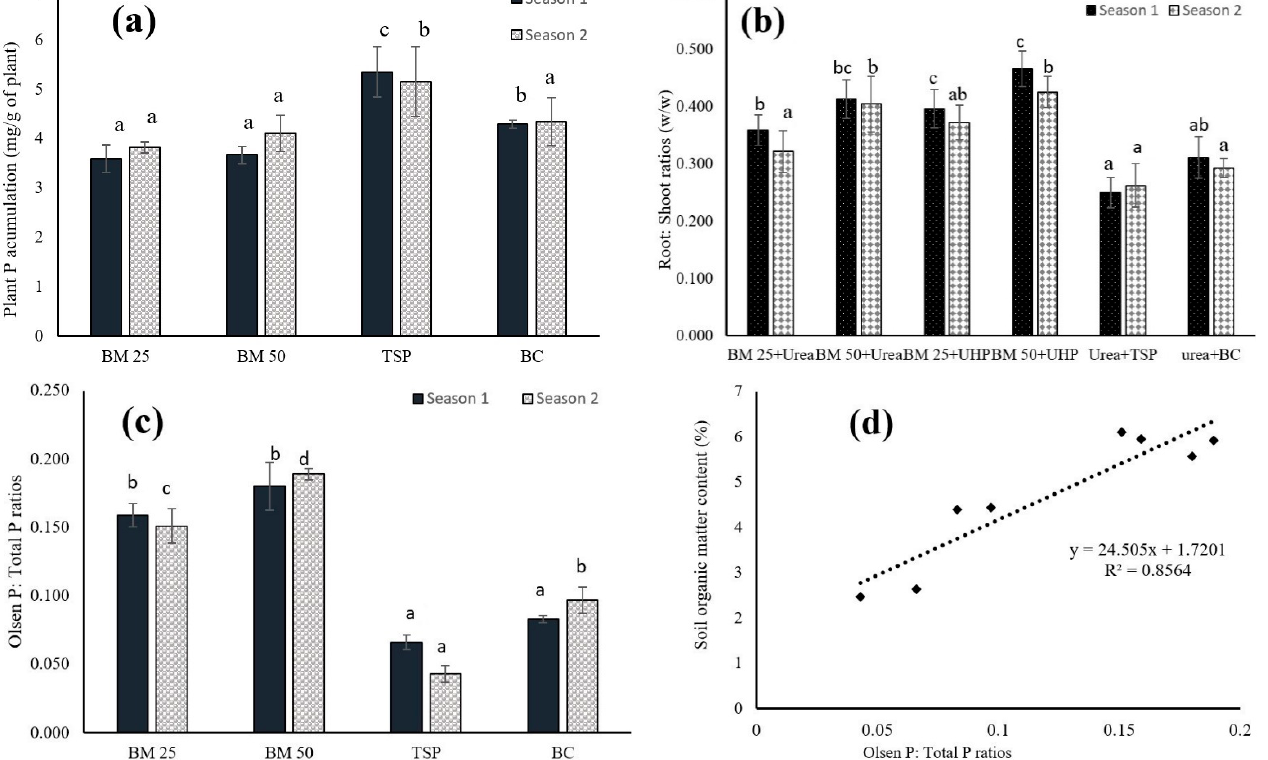
Figure 1. ( a ) Quantity of P accumulated into the leaf lettuce from the two seasons, ( b ) root: shoot ratios of the leaf lettuce produced with the different amendments, ( c ) Olsen P: total P ratios of the soil amended with the different P sources, ( d ) linear relationship between Olsen P: total P and soil organic matter content of the soil.